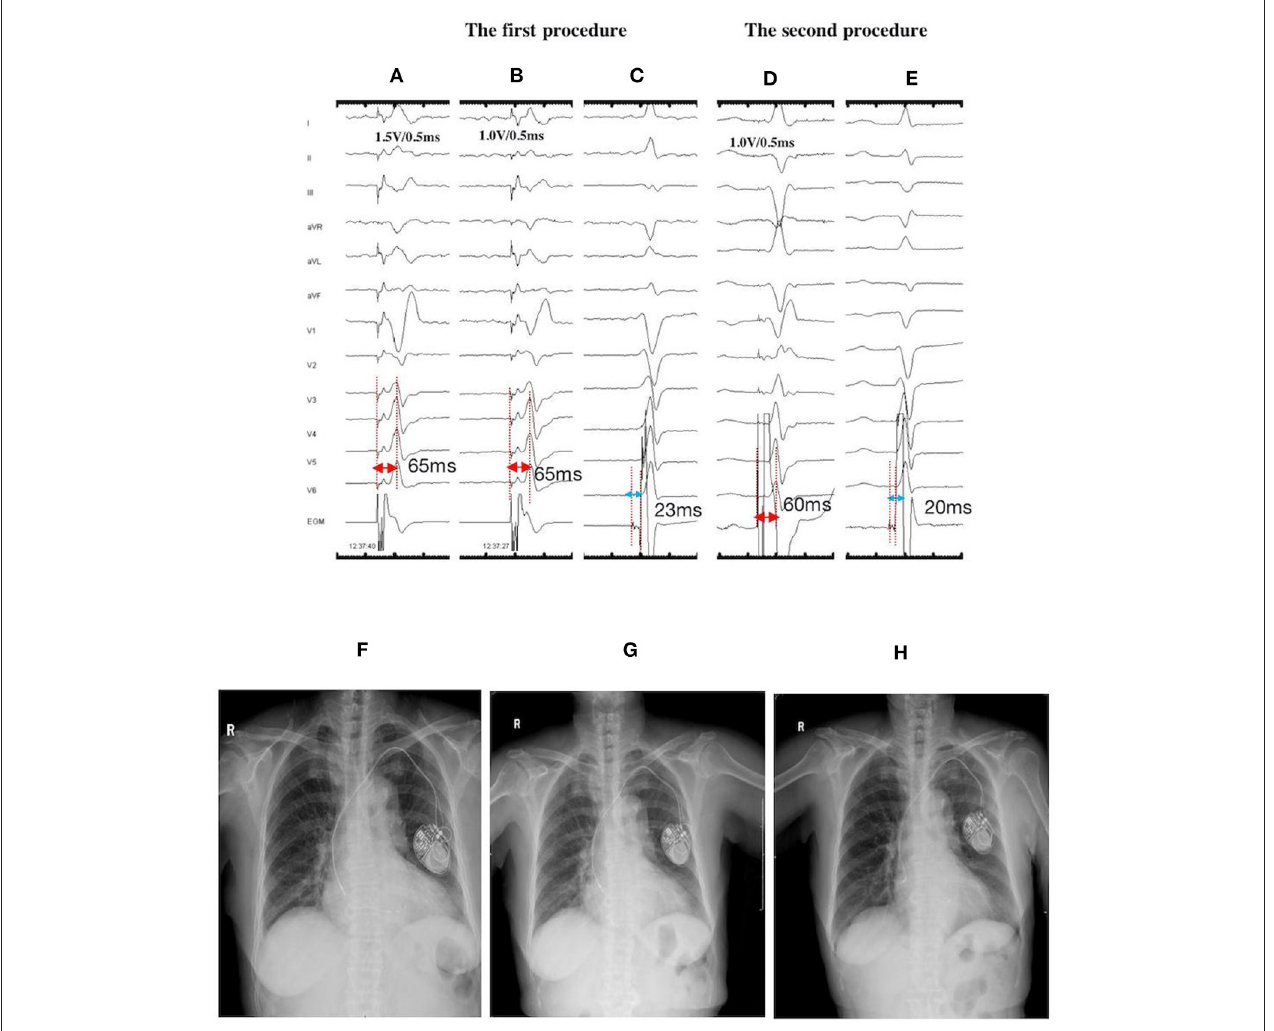
FIGURE 3 | ECGs, EGMs, and fluoroscopic images of a 77-year-old female with LBBP lead dislodgement at the 1-month postoperative follow-up: During the first procedure: NSLBBP at 1.5 V/0.5ms (A) and SLBBP at 1.0 V/0.5ms (B) with the same Sti-LVAT of 65ms; (C) Po LBB during intrinsic rhythm with the Po LBB -V interval of 23ms; During the second procedure: (D) NSLBBP at 1.0 V/0.5ms, with the Sti-LVAT of 60ms; (E) Po LBB during intrinsic rhythm, with the PoLBB-V interval of 20ms; X-ray films illustrating lead locations: (F) on the second day after the first procedure, (G) at the 1-month follow-up exhibiting lead dislodgement, and (H) on the second day after lead repositioning. ECG, electrocardiogram; EGM, electrogram; LBBP, left bundle branch pacing; NSLBBP, nonselective left bundle branch pacing; SLBBP, selective left bundle branch pacing; Sti-LVAT, stimulus to left ventricular activivation time; Po LBB, left bundle branch potential; Po LBB -V, left bundle branch potential to